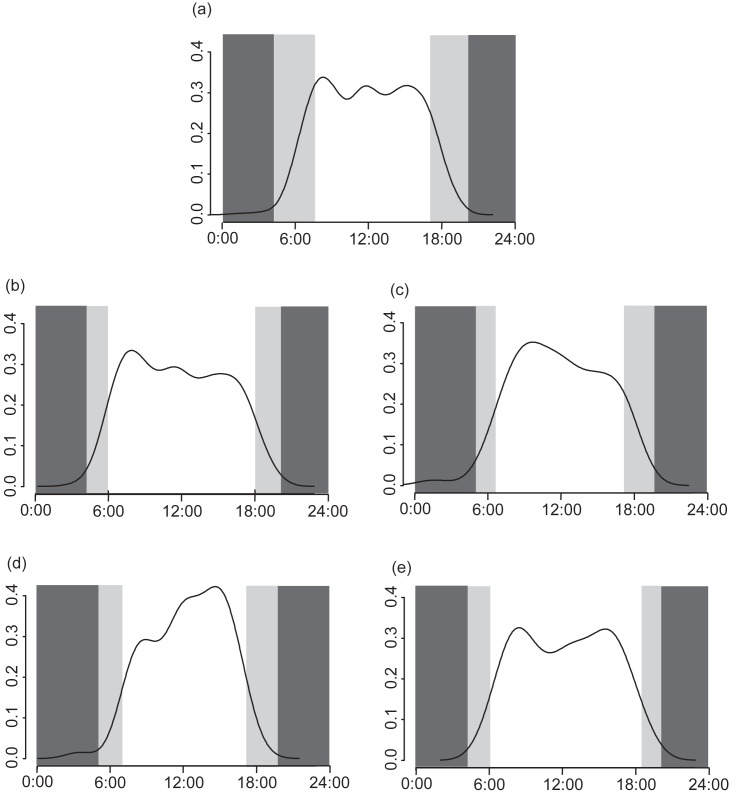
Daily activity patterns of Japanese macaques.Y axis and the curves are the kernel density estimates of the filming events. Light gray areas represent one hour before sunrise and one hour after sunset, and dark gray areas represent nighttime; note that the widths of these areas vary among seasons due to the fluctuating time of sunrise and sunset. (a) All seasons combined, (b) summer (July, August and September), (c) fall (October and November), (d) winter (December, January, February and March), and (e) spring (April, May and June).